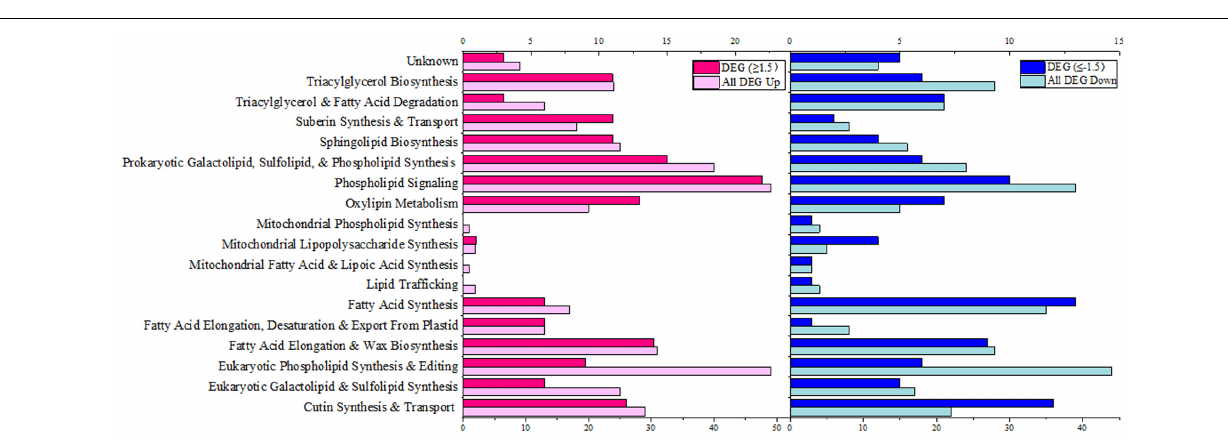
LPAT5 , CCT , PAH , FAD2, and PLD ), implying a